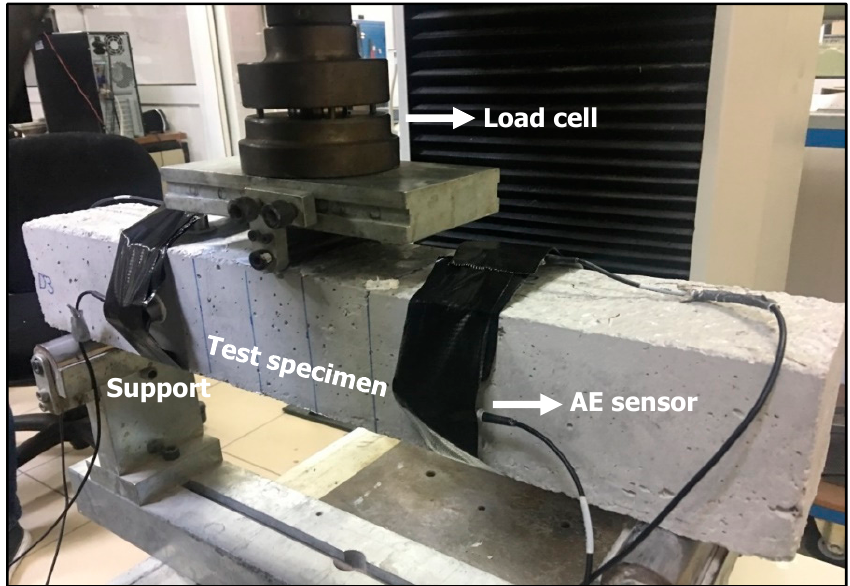
Figure 4. Flexure test.